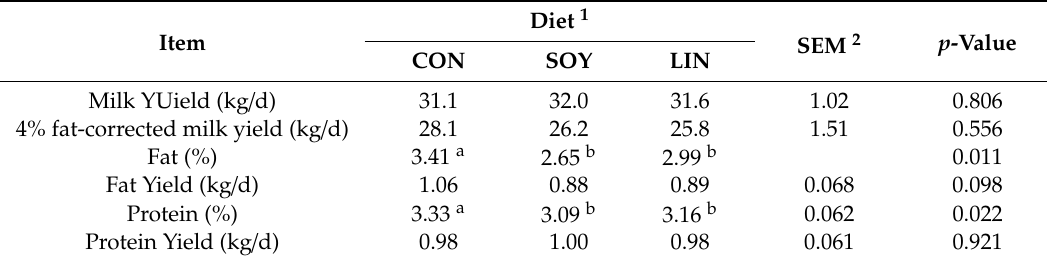
Table 3. Dry matter intake, milk yield, and milk composition.